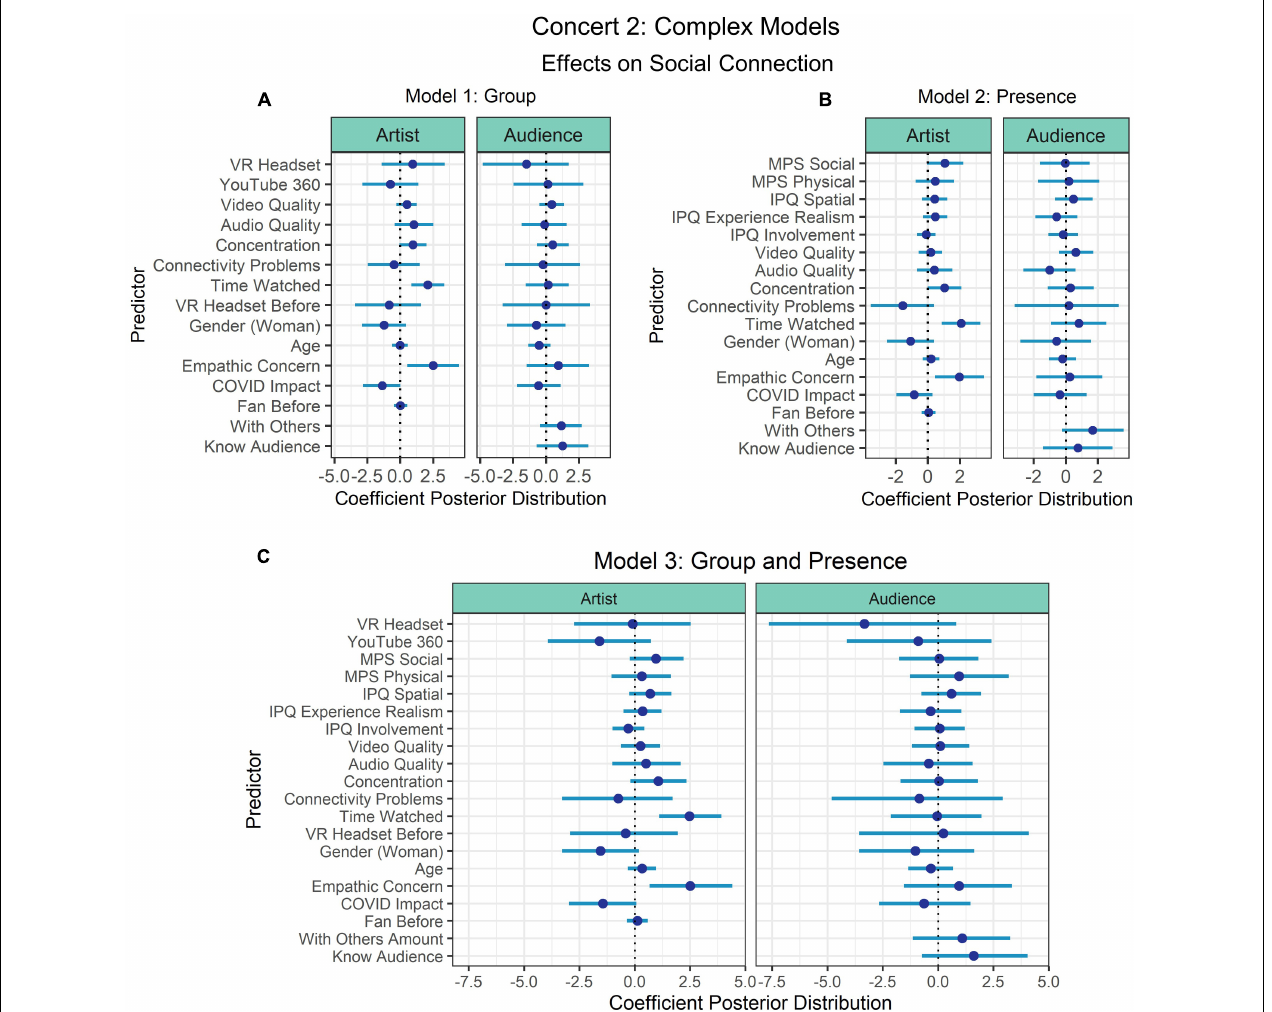
FIGURE 6 | Concert 2’s complex models’ predictor coefficient estimates (points) and 90% credible intervals (lines) for the effects on social connection to the artist (left) and audience (right). Three models were fit to examine the individual effects of (A) Group and (B) Presence, and the third model examined the combined effects of Group and Presence (C)